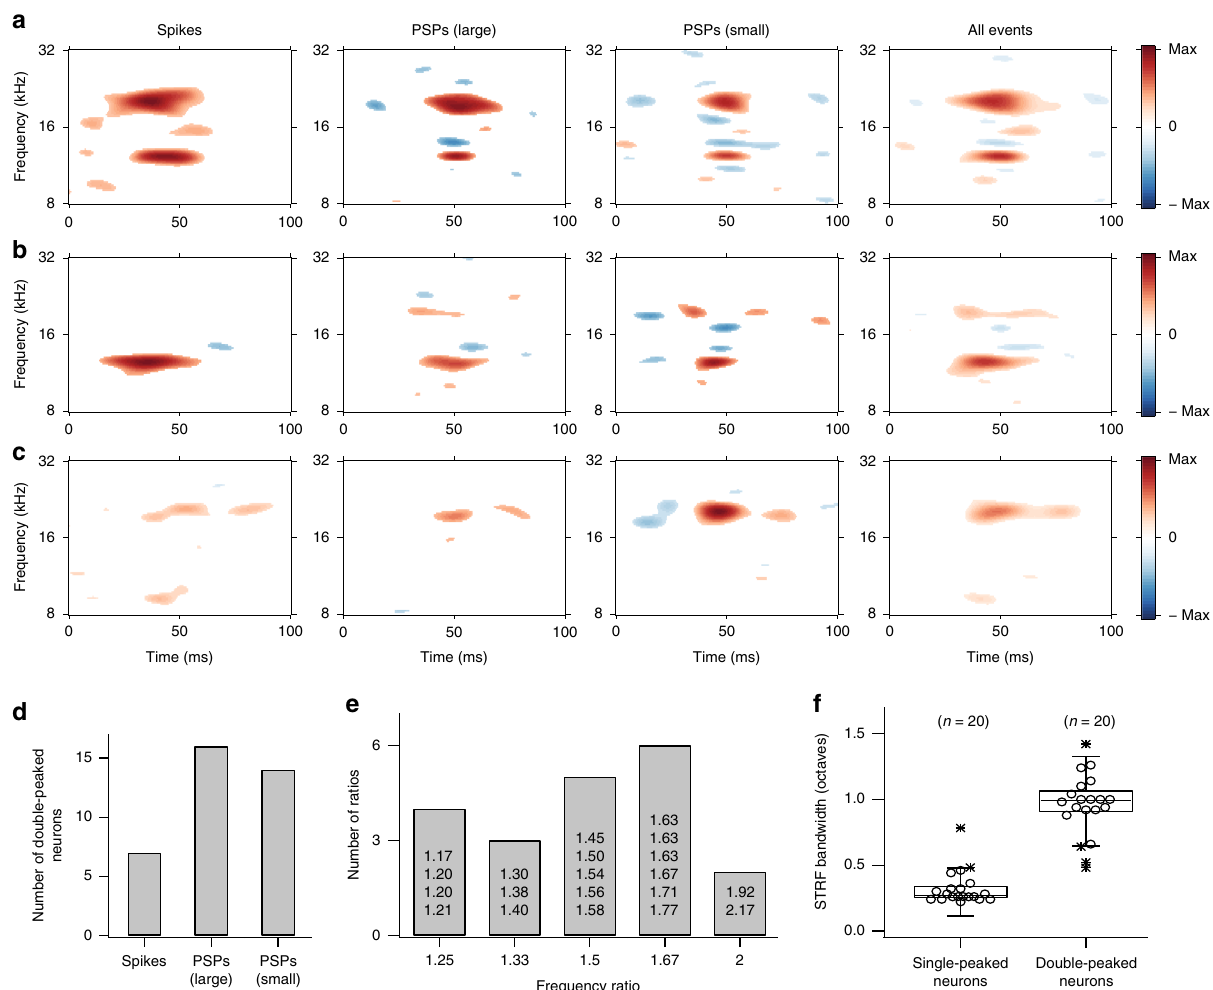
Fig. 3 Properties of double-peaked neurons in response to the DMR stimulus. Three representative double-peaked neuron responses ( a – c ) are illustrated. Each row was obtained from a different animal. a All STRFs showed double-peaked responses at ~12.3 kHz and ~20.0 kHz with a ratio of 1.63 and had a bandwidth of ~0.98 octaves. The number of peaks included in computing each STRF was 1147 for spikes, 660 for large PSPs, 1361 for small PSPs, and all number of peaks for all events. b The PSP STRFs showed double-peaked responses at ~12.6 kHz and ~19.4 kHz with a ratio of 1.54 and had a bandwidth of ~0.94 octaves. The number of peaks included in computing each STRF was 1220 for spikes, 1591 for large PSPs, 1215 for small PSPs, and all number of peaks for all events. c The spike STRF had double-peaked responses at ~9.3 kHz and ~20.2 kHz with a ratio of 2.17 and a bandwidth of ~1.36 octaves. The number of peaks included in computing each STRF was 1028 for spikes, 424 for large PSPs, 708 for small PSPs, and all number of peaks for all events. d Quanti fi cation of double-peaked responses. e Harmonically related double-peaked responses. Each bar graph shows raw frequency ratios added to counting. Ratios were estimated from STRFs for all events. f The bandwidth comparison between single-peaked and double-peaked neurons. STRF bandwidths were estimated from all events. The lower and upper hinges are at the 25 (Q25) and 75 (Q75) percentiles, respectively. The median bandwidth values, the middle line between hinges, were 0.28 for single-peaked neurons and 0.96 for double-peaked neurons. The lower and upper inner fences are set at Q25 − 1.5×(Q75 − Q25) and Q75 + 1.5×(Q75 − Q25), respectively. Outliers beyond inner fences are indicated by